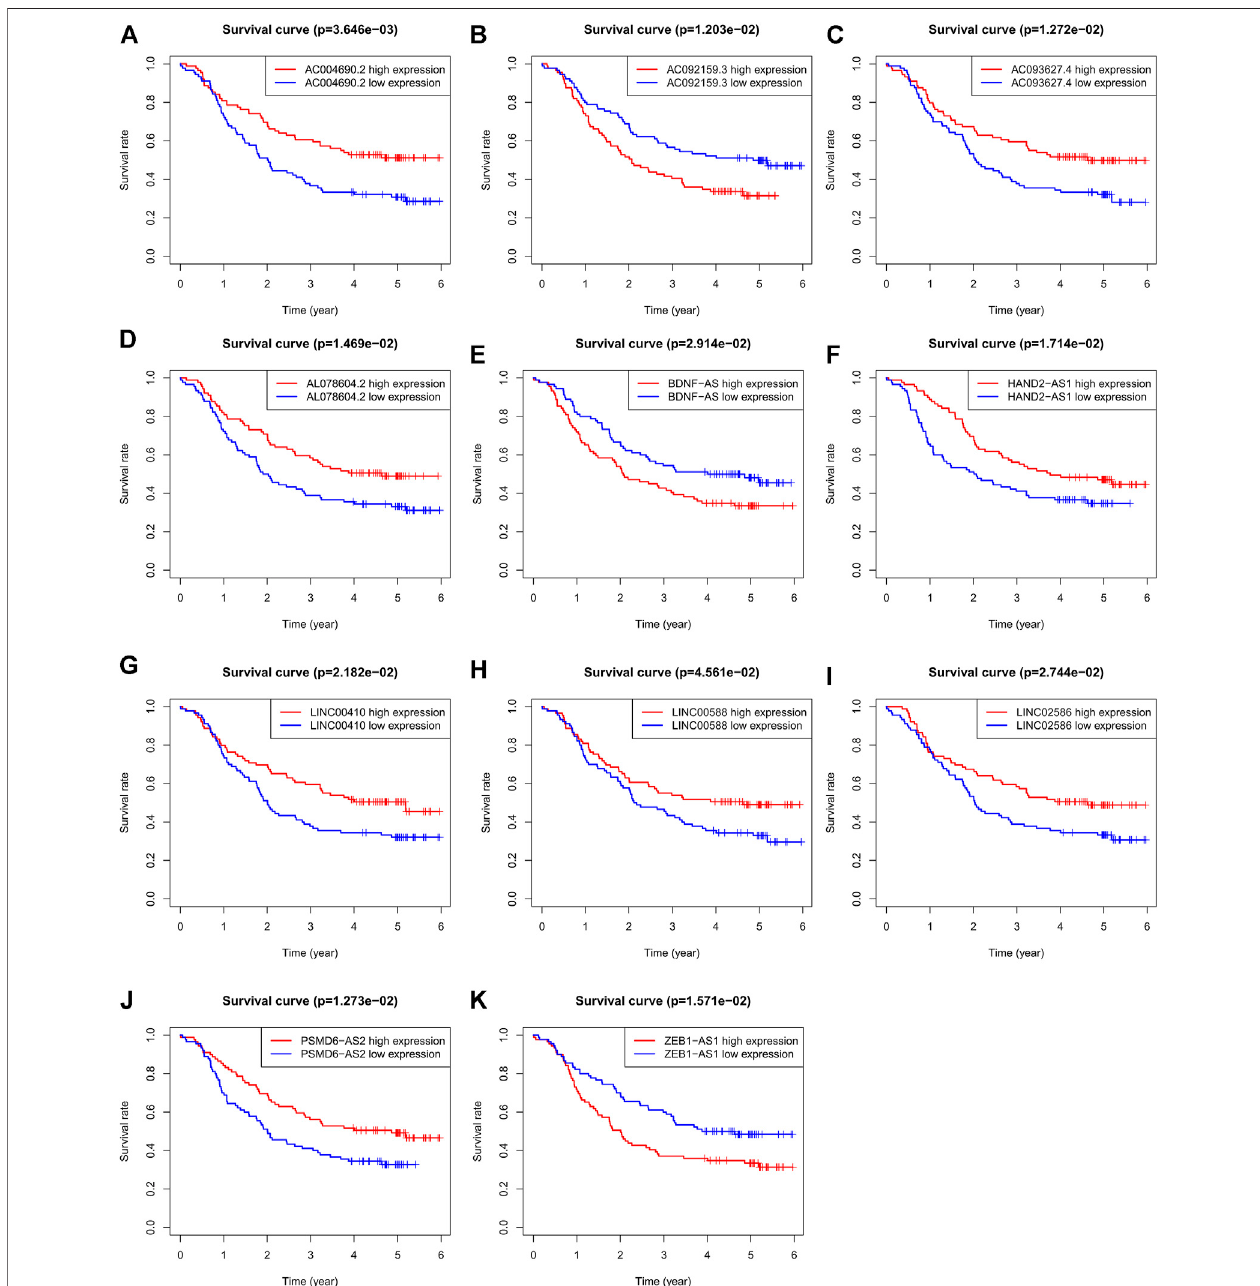
FIGURE 2 | KM analysis of the 11 autophagy-related lncRNAs in GSE63625 ESCC patients. (A) : OS curves of ESCC patients based on AC004690.2 expression. (B) : OS curves of ESCC patients based on AC092159.3 expression. (C) : OS curves of ESCC patients based on AC093627.4 expression. (D) : OS curves of ESCC patients based on AL078604.2 expression. (E) : OS curves of ESCC patients based on BDNF-AS expression. (F) : OS curves of ESCC patients based on HAND2-AS1 expression. (G) : OS curves of ESCC patients based on LINC00410 expression. (H) : OS curves of ESCC patients based on LINC00588 expression. (I) : OS curves of ESCC patients based on LINC02586 expression. (J) : OS curves of ESCC patients based on PSMD6-AS2 expression. (K) : OS curves of ESCC patients based on ZEB1-AS1 expression.